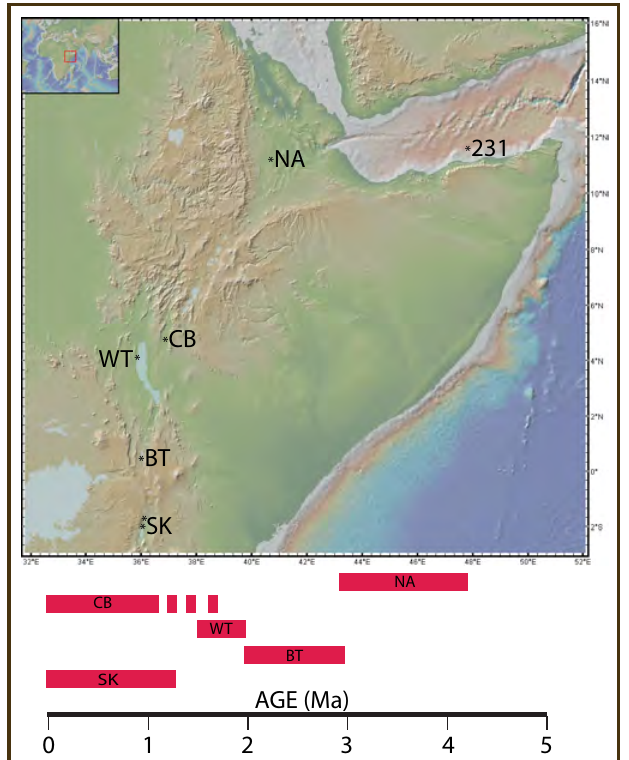
Figure 2. Map showing areas under active consideration for HSPDP drilling and stratigraphic ranges covered by each area. NA=Northern Awash River Valley, Northern Afar; CB=Chew Bahir; WT=West Turkana; BT=Baringo-Tugen Hills; SK=Southern Kenya. Gulf of Aden DSDP Drill Site 231, discussed in the text, is also shown. Base map developed with GeoMapApp©.